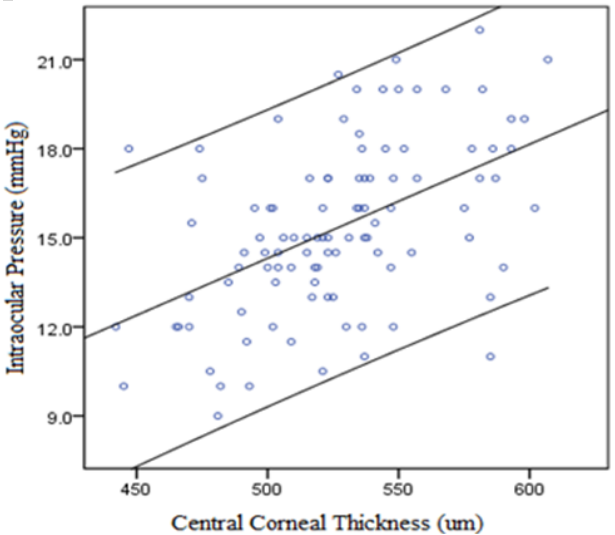
Figure 5: Scatter plot showing the correlation of CCT and IOP of the Indian subjects with 95% confidence interval of the re - gression line. R 2 = 0.248, r = 0.498, p = 0.001). The regression 0.038CCT_ line represents IOP =